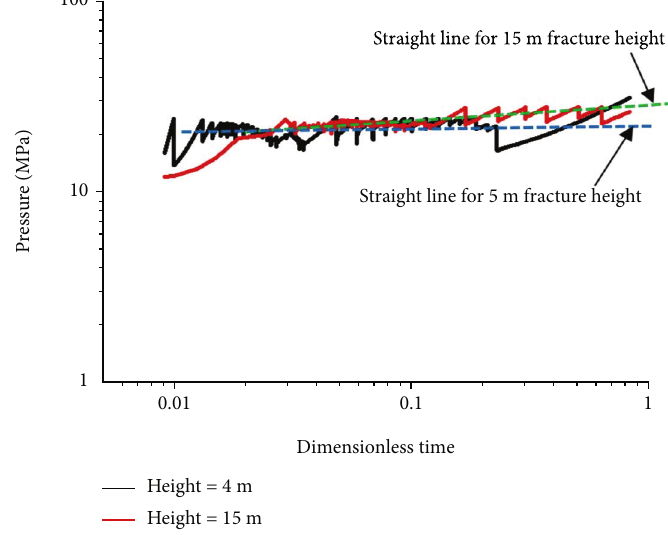
Figure 10: Comparison of the log-log plot of net pressure history in the case of 4m/15 m formation